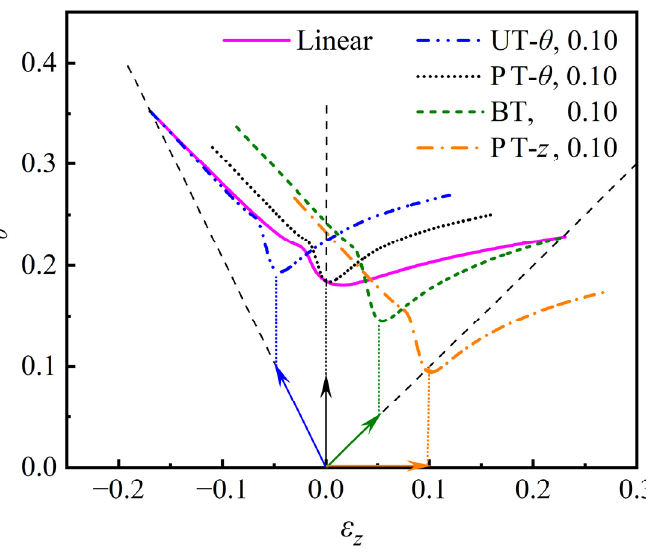
Figure 10. ε -FLCs of the AA6061 tube predicted by the M-K+DF2012 model under different pre-strain conditions.